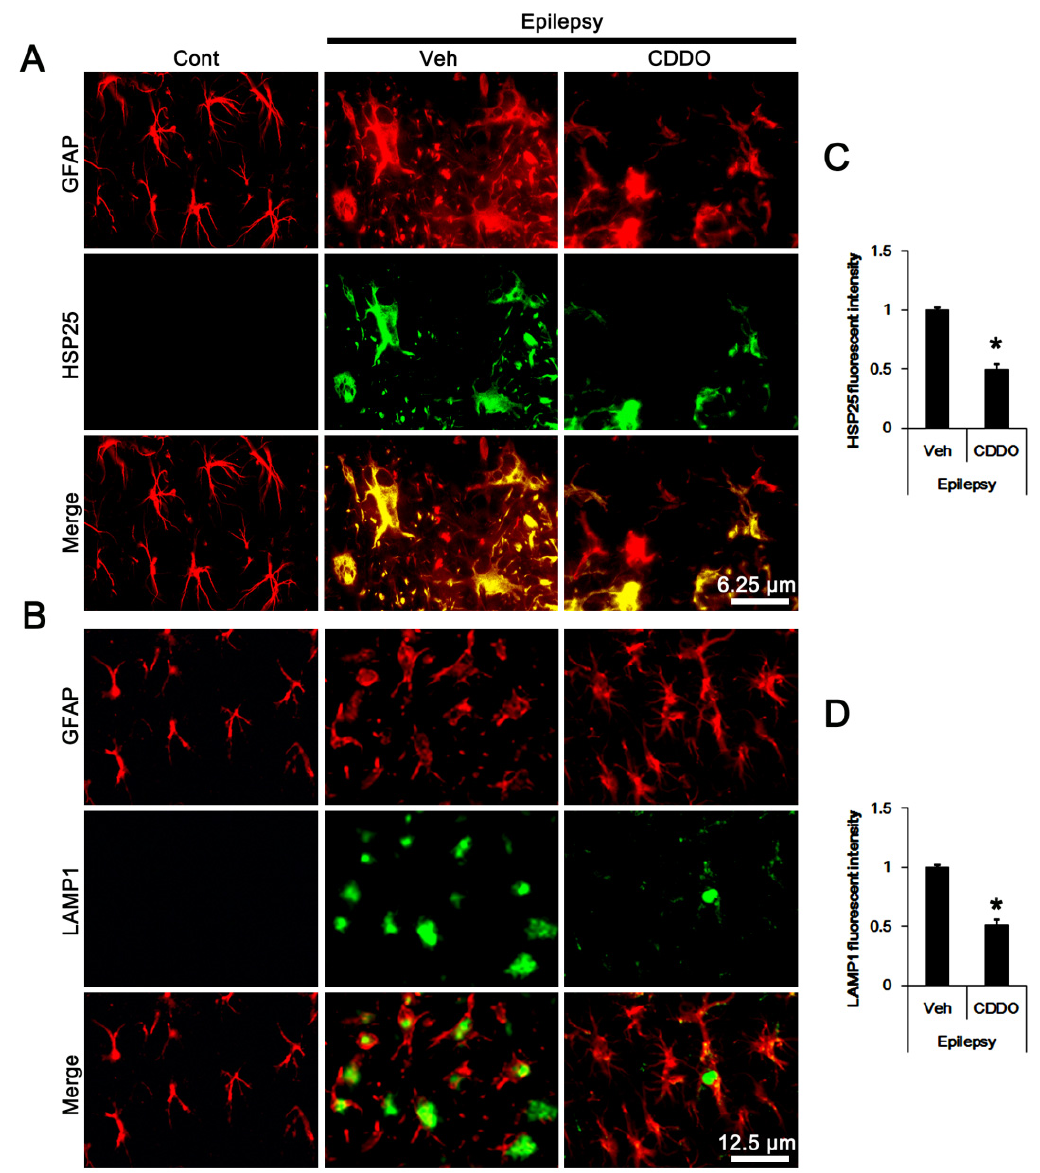
Figure 2. Effects of CDDO-Me on HSP25 and LAMP1 expressions in CA1 astrocytes in control and epileptic rats. As compared to control animals (Cont), expressions of heat shock protein 25 (HSP25) and lysosomal-associated membrane protein 1 (LAMP1) were increased in CA1 astrocytes in epileptic rats. CDDO-Me decreased both HSP25 and LAMP1 expressions in CA1 astrocytes, as compared to vehicle (Veh). ( A,B ) Representative photos demonstrating astroglial HSP25 ( A ) and LAMP1 ( B ) expressions in CA1 astrocytes. ( C,D ) Quantifications of HSP25 ( C ) and LAMP1 ( D ) expression in CA1 astrocytes. Error bars indicate SEM ( * p < 0.05 vs. vehicle-treated epileptic rats, respectively; n = 7). Western blots showed the increase in LAMP1 expression in the epileptic hippocampus ( t (12) = 16.1, p < 0.00001 vs. control animals, Student t -test, n = 7, respectively; Figure 3A,B), accompanied by upregulated HSP25 and phospho (p)-HSP25 levels (Figure 3A). In con- trast, p-ERK1/2 level was significantly lower in the epileptic hippocampus than